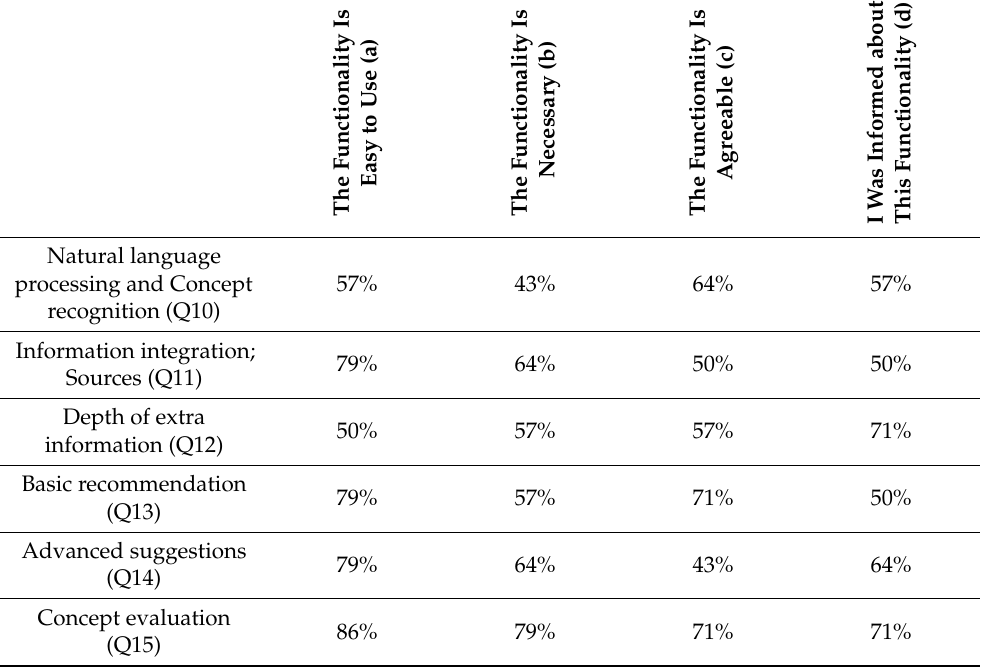
Table 2. Results of the questionnaire for Task